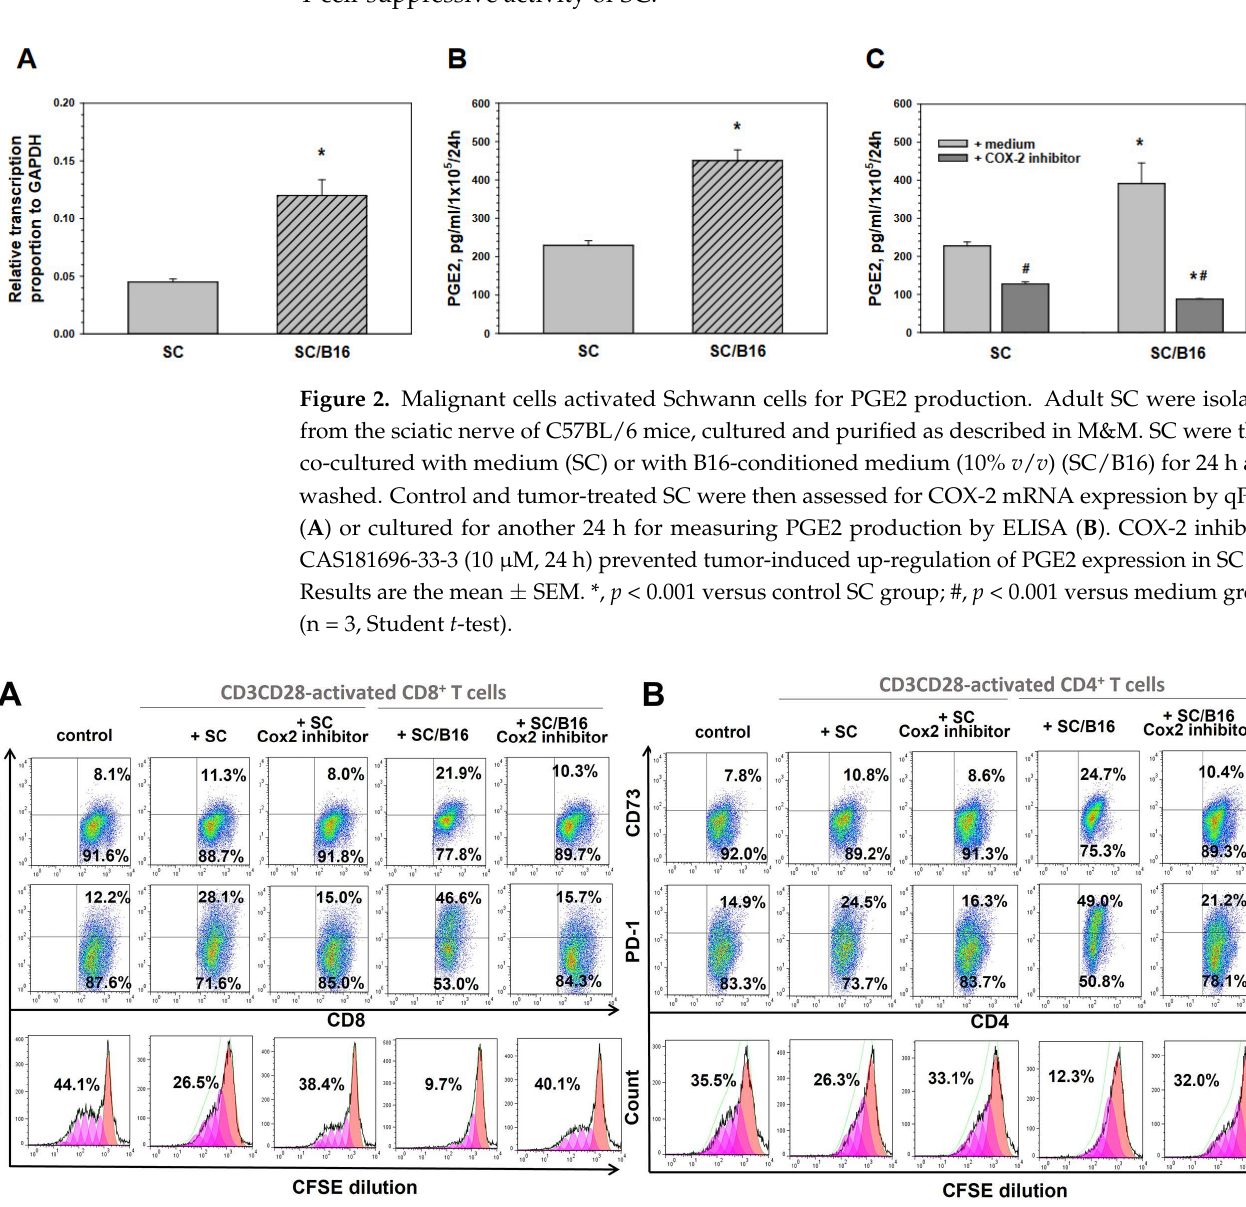
Figure 3. COX-2 inhibition prevented T cell exhaustion induced by tumor-activated SC. Adult